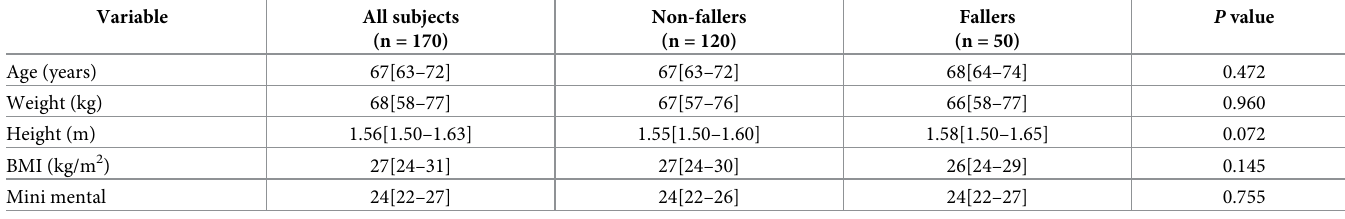
Table 1. Characteristic of the participants.